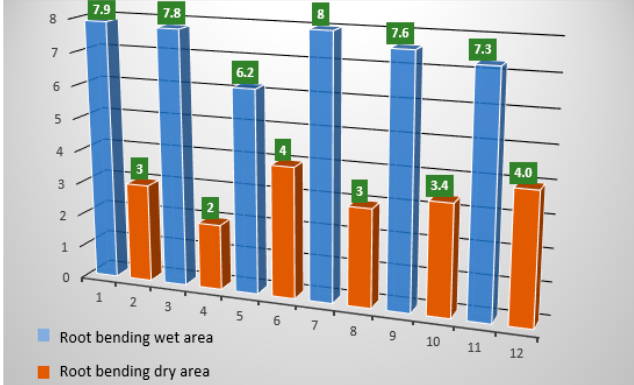
Figure 3. Root growth toward moisture in both dry and wet soil.